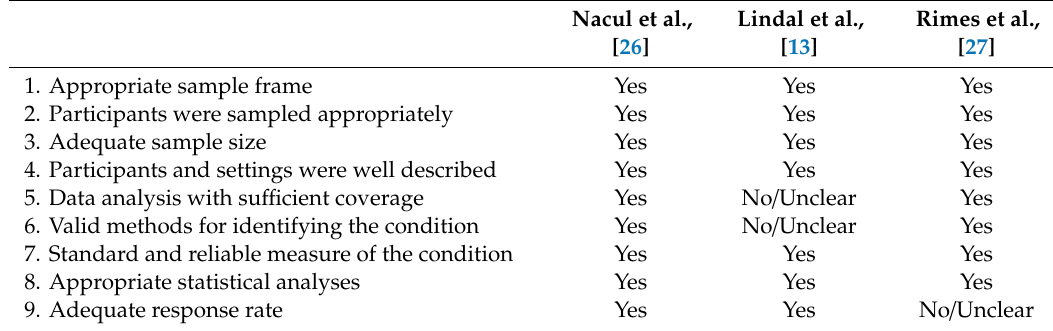
Table 3. The methodological quality of the included studies evaluated by the Joanna Briggs Institute-Checklist for Prevalence